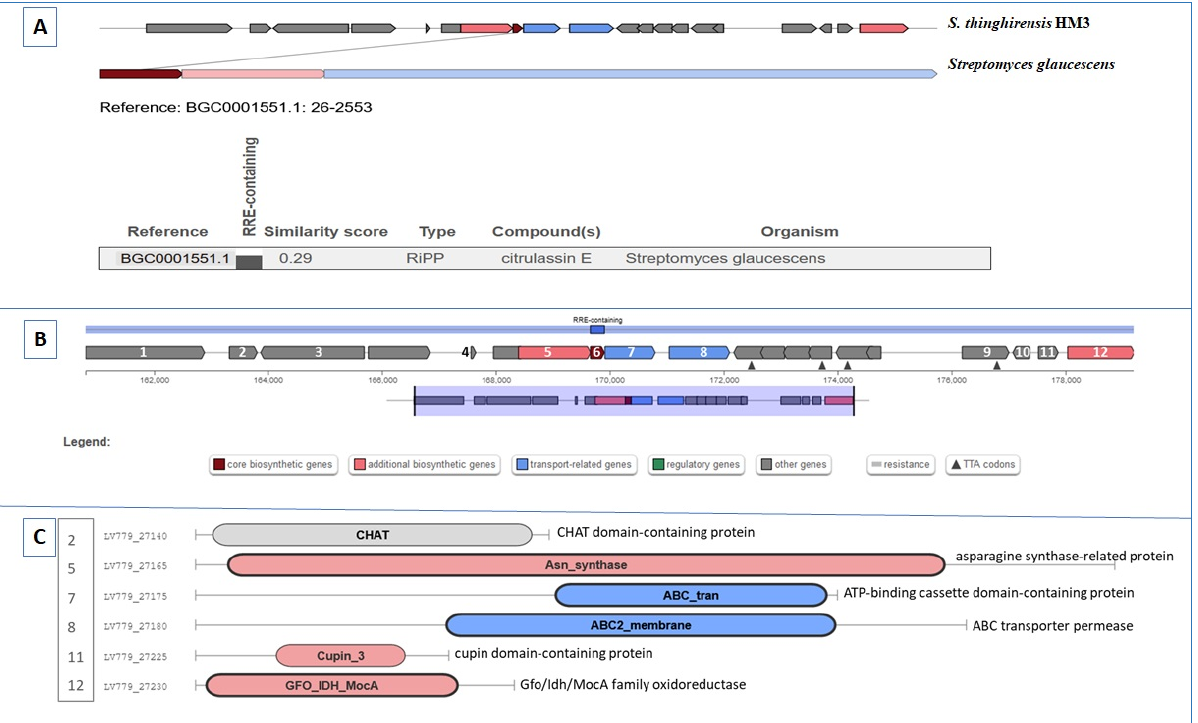
Figure 8. RiPP biosynthetic gene cluster in S. thinghirensis HM3. ( A ) The MIBiG comparison between the proposed RiPP BGC in strain HM3 and the proposed identified cluster of citrulassin E in S. glaucescens with a similarity score of 0.29. ( B ) The proposed RiPP BGC in region 50.1 of the genome; 1, tetratricopeptide repeat protein; 3, LuxR C-terminal-related transcriptional regulator; 4, lasso RiPP family leader peptide-containing protein; 6, PqqD family protein; 9, bile acid:sodium symporter family protein; 10, GNAT family N-acetyltransferase. ( C ) represents the Pfam domains involved in RiPP biosynthesis.